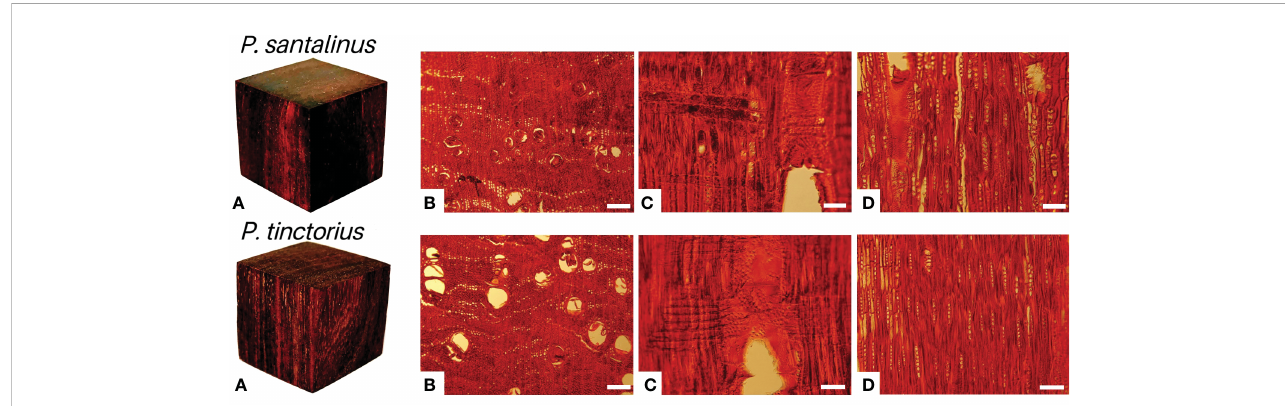
FIGURE 1 Macroscopic (A) and microscopic photographs (B – D) of P. santalinus and P. tinctorius . (B – D) -Transverse, radial and tangential sections of P. santalinus and P. tinctorius , respectively. Scale bars, 200 m m (B) and 100 m m (C, D)